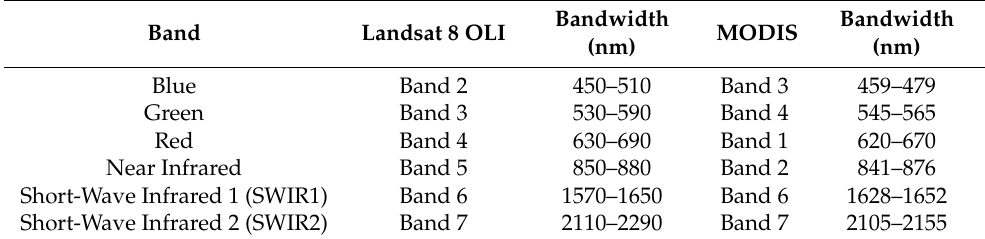
Table 1. Information of corresponding bands of Landsat8 OLI, and MODIS.